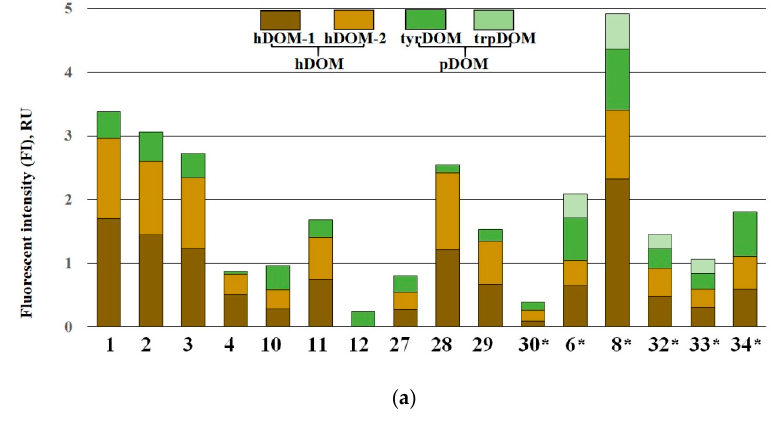
Figure 5. Distribution of fluorescent DOM (fDOM). ( a ) The molecular fractions of fDOM; ( b ) Distribution of the integral humic-like DOM (hDOM) and protein-like DOM (pDOM) values normalized to Dissolved organic carbon (DOC) concentration (Carbon-normalized values). * tabular ground ice (TGI) samples are marked with an asterisk.